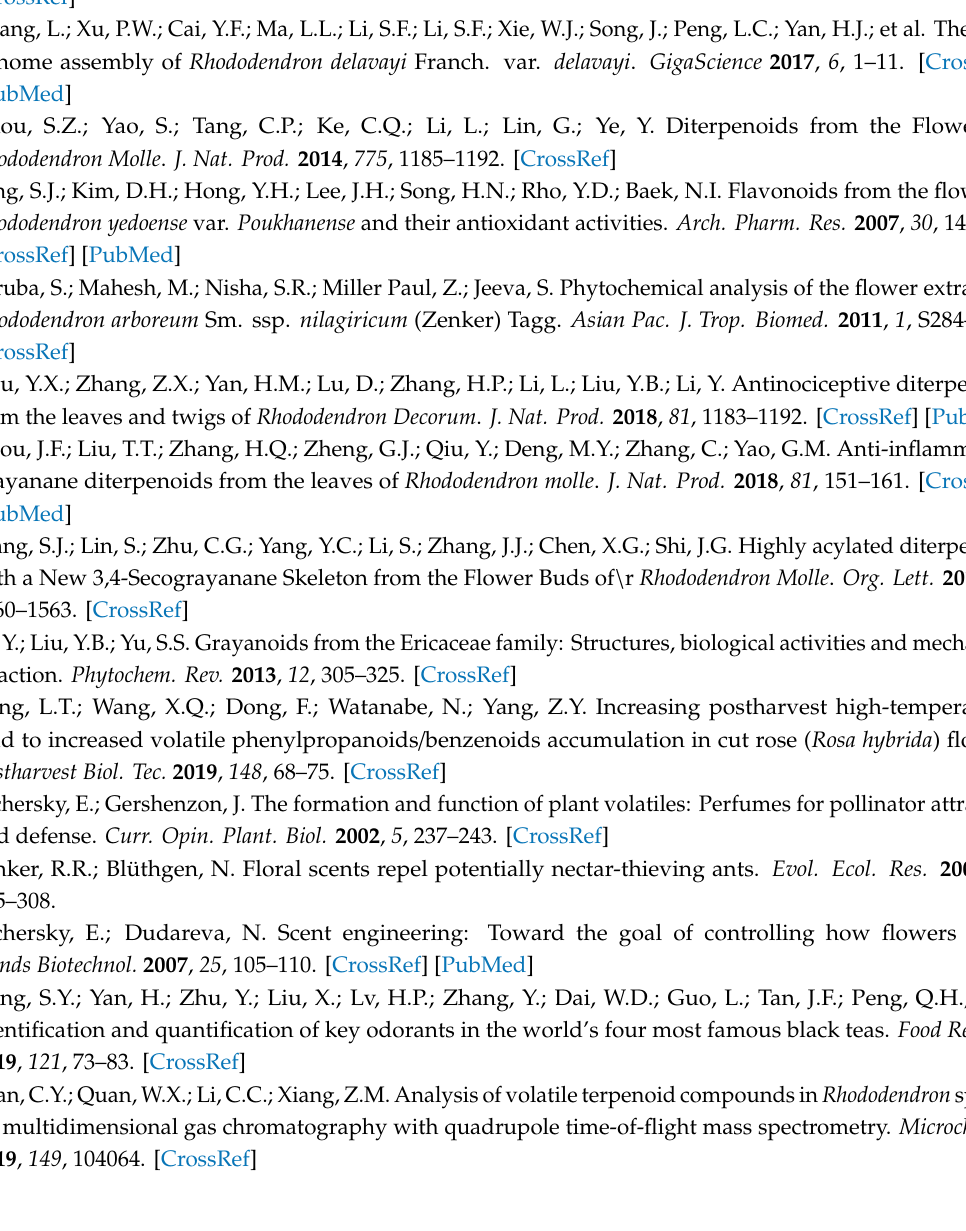
Table S1. Complete compound information for identification; Table S2. Compound contents in Rhododendron flowers of di ff erent species and their odor